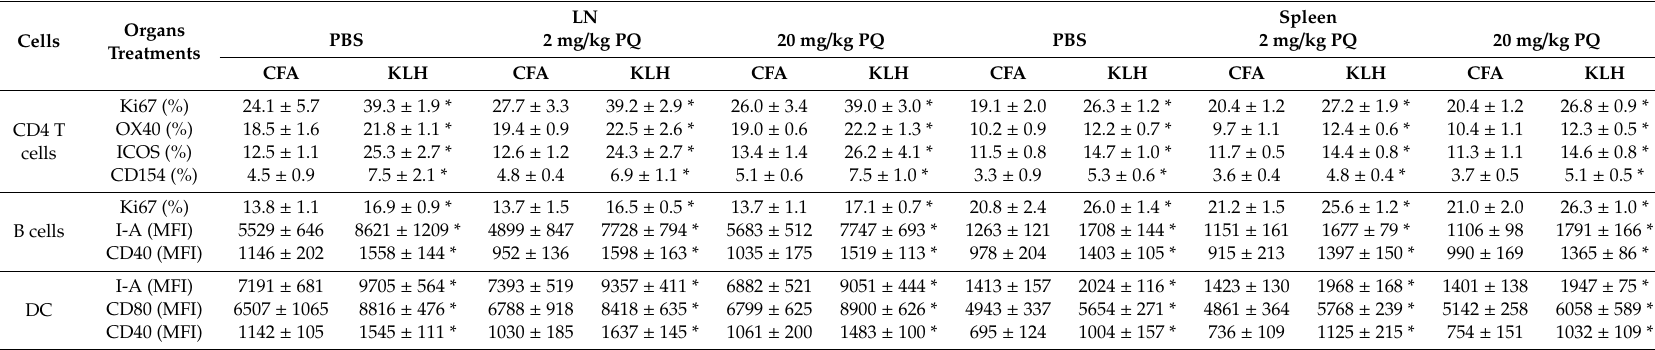
Table 1. Assessment of leukocyte co-stimulatory marker expression and lymphocyte proliferation in mice treated with PQ at day 4 post the first KLH immunization.